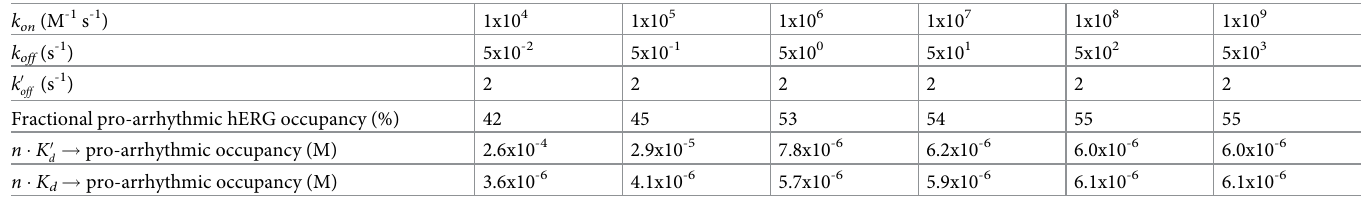
Table 3. L 0 (expressed as n � K d and n � K d 0 ) for a set of hypothetical hERG blockers resulting in the pro-arrhythmic fractional channel occupancy levels predicted from our AP simulations. Blocker K d = 5 μ M in all cases, where k on ranges between 1x10 4 and 1x10 9 M -1 s -1 and k off between 0.005 and 5,000 (noting that the pro-arrhyth- mic occupancy level increases as k speeds). n � K was back-calculated from the predicted pro-arrhythmic occupancy using Eq 19. off d